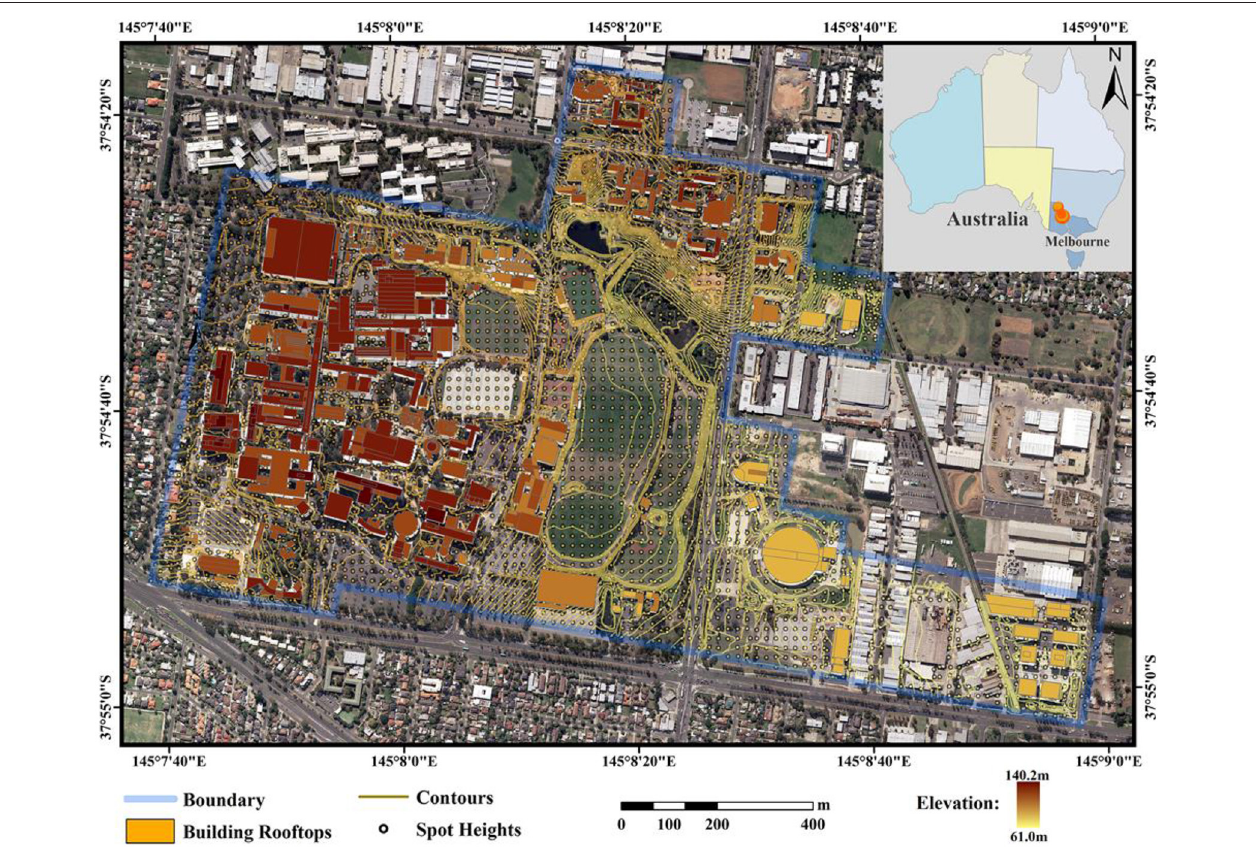
FIGURE 1 | Study area: Monash Clayton Campus, Melbourne, Australia. Spatial data provided by Strategic and Planning Information (SPI) service at Monash University. The data was originally captured and compiled from aerial photography flown on 30 and 31 January 2010. Reference systems used for this study are: (i) horizontal datum: Geocentric Datum of Australia GDA94, (ii) vertical datum: Australian Height Datum (AHD), (iii) map projection in Map Grid of Australia (MGA) Zone 55 and (iv) geoid model Ausgeoid98 for heights (Radosevic et al., 2020).